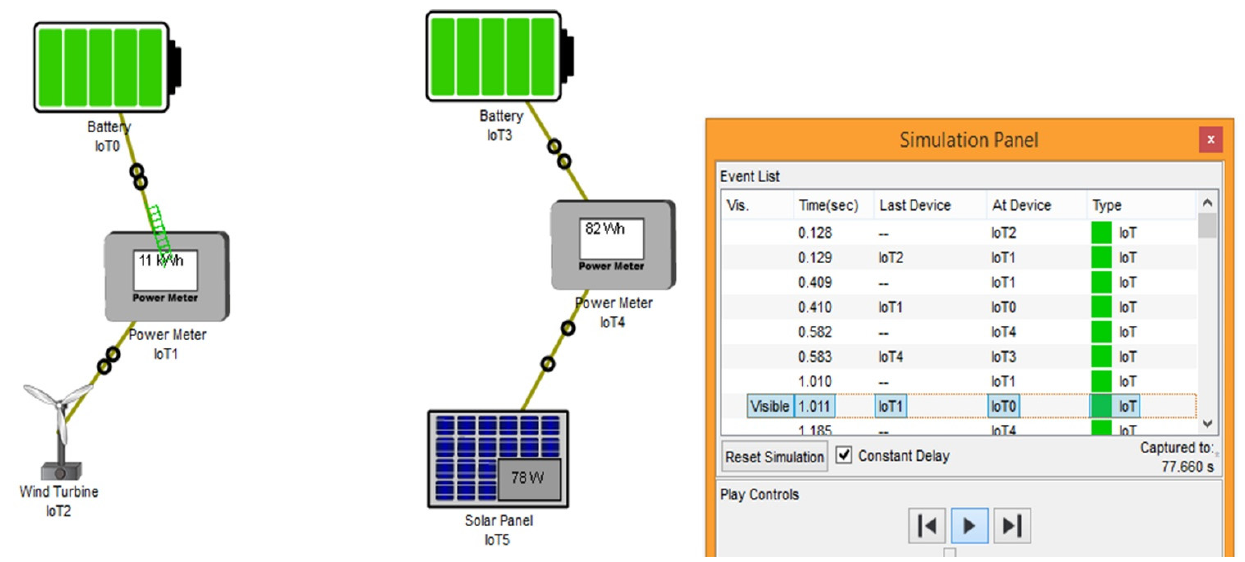
Figure 9. Sensor node energy conservation using renewable resources in an agriculture field.